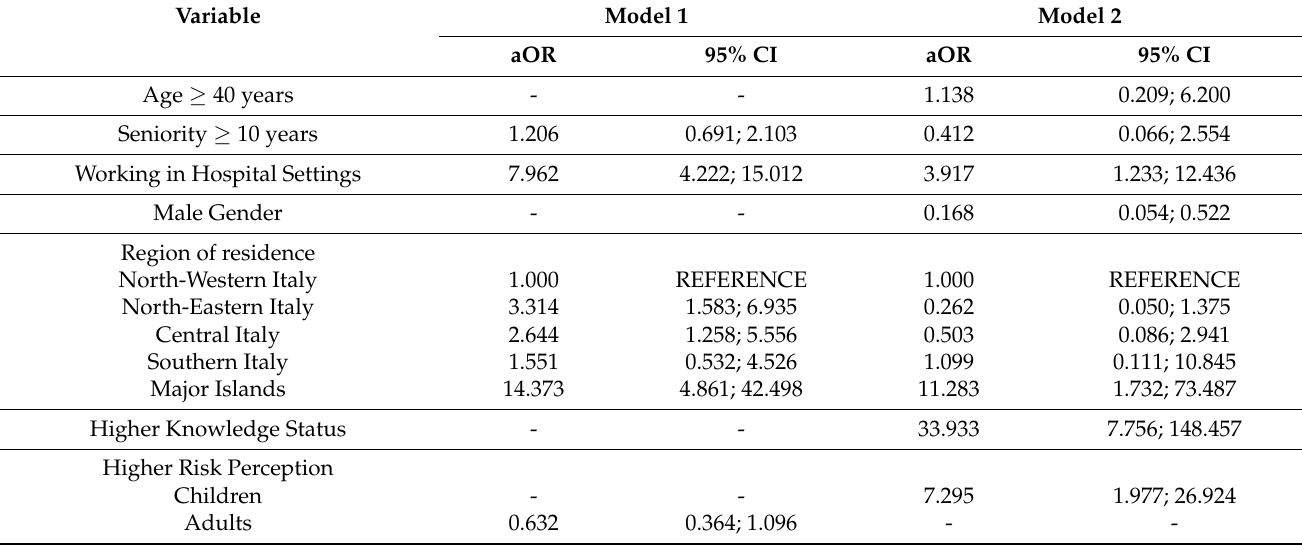
Table 5. Multivariable analysis of factors associated with (a) having previously (i.e., in the 5 years before the present survey) managed any respiratory syncytial virus (RSV) case (all respondents, No. 389; Model 1) and (b) having previously employed monoclonal antibodies targeting RSV as preventive therapy (only participants having previously managed a RSV case; No. 163). Adjusted Odds Ratios (adjOR) and their respective 95% confidence intervals were calculated through binary logistic regression analysis. In both models, all factors that in univariate analysis were associated with the outcome variables with p < 0.100 were included as explanatory